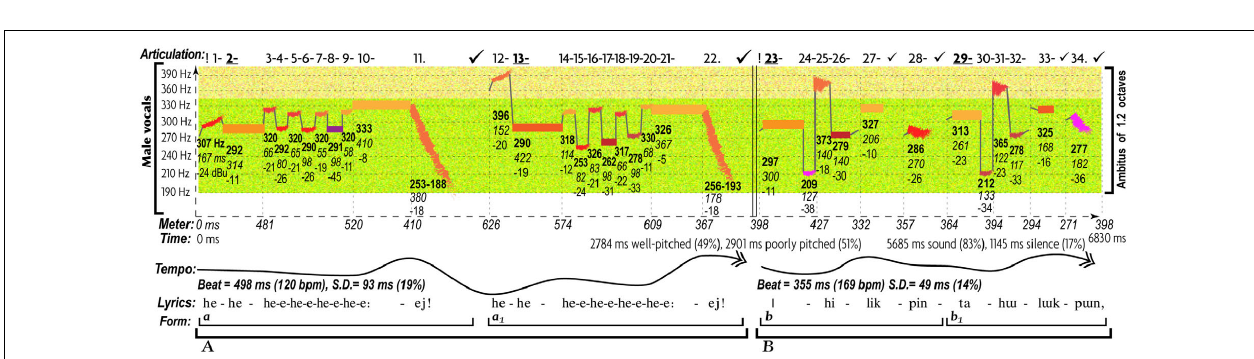
FIGURE 3 | Characteristic patterns of AEs in expression of anger in a song of the underworld virgin from the olonkho “Djiribina Djirilatta” (http://chirb.it/sCq02k). This excerpt from the traditional Yakut epic expresses anger of the evil sorcerer toward the heroine, challenging her to a fight (Alekseyev and Nikolayeva, 1981, 35). Structural descriptors of most aspects of this song fall in the category of “angry” music (Juslin, 2005). The acoustic markers of all AEs contrast those in Figure 2 . The ambitus is over twice wider. There are two registers instead of one: low singing and high “shouting”), both are higher than Figure 2 . The share of well-pitched sounds in the overall duration of music is reduced by 34%. The share of staccato articulation is increased (by 142% in the duration of silence and 40% in the number of pauses). Tones are overall shorter and 50% more diverse in time values, with contrasts between rhythmic groups. The tempo contains abrupt switches, the fastest of which is 66% faster and 73% more variable (rubato) than Figure 2 . Intonations feature wide leaps, on average 70% wider than Figure 2 . Thematically, the music is more diverse and complex, using two contrasting materials, “A” and “B” ( Figure 2 had only one). Timbre is harsh (a heightened larynx and intensified pressure).